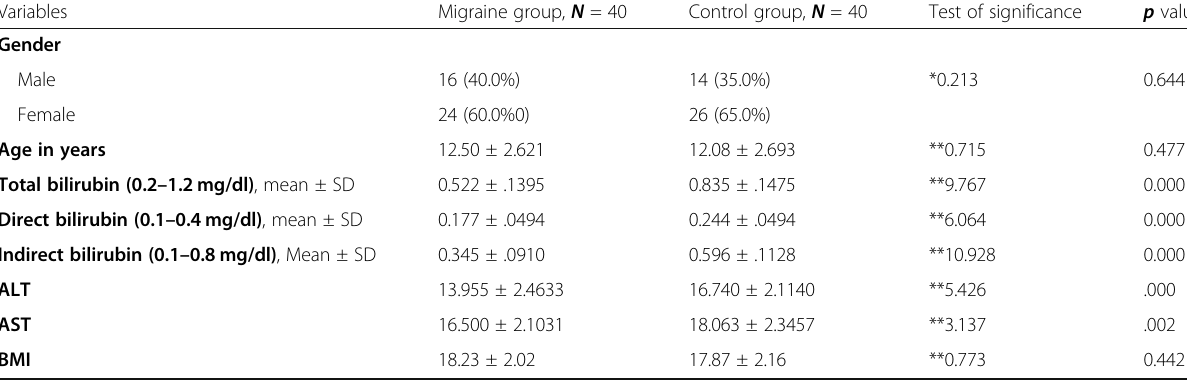
Table 1 Demographics and laboratory data of the migraine and control groups